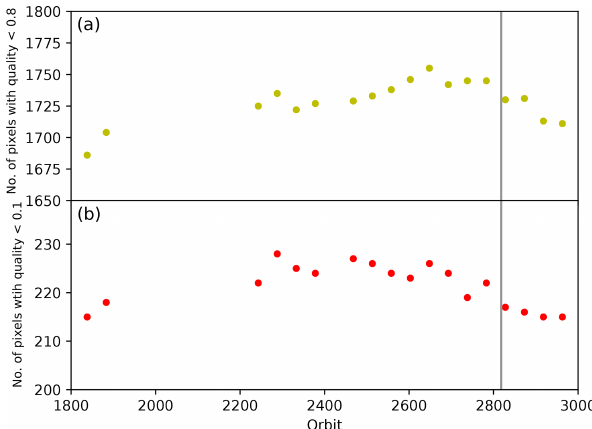
Figure 12. Number of dead ( b , red dots) and bad ( a , yellow dots) pixels. The pixel quality is expressed as a number between 0 and 1. The dotted line is a linear fit through the data.